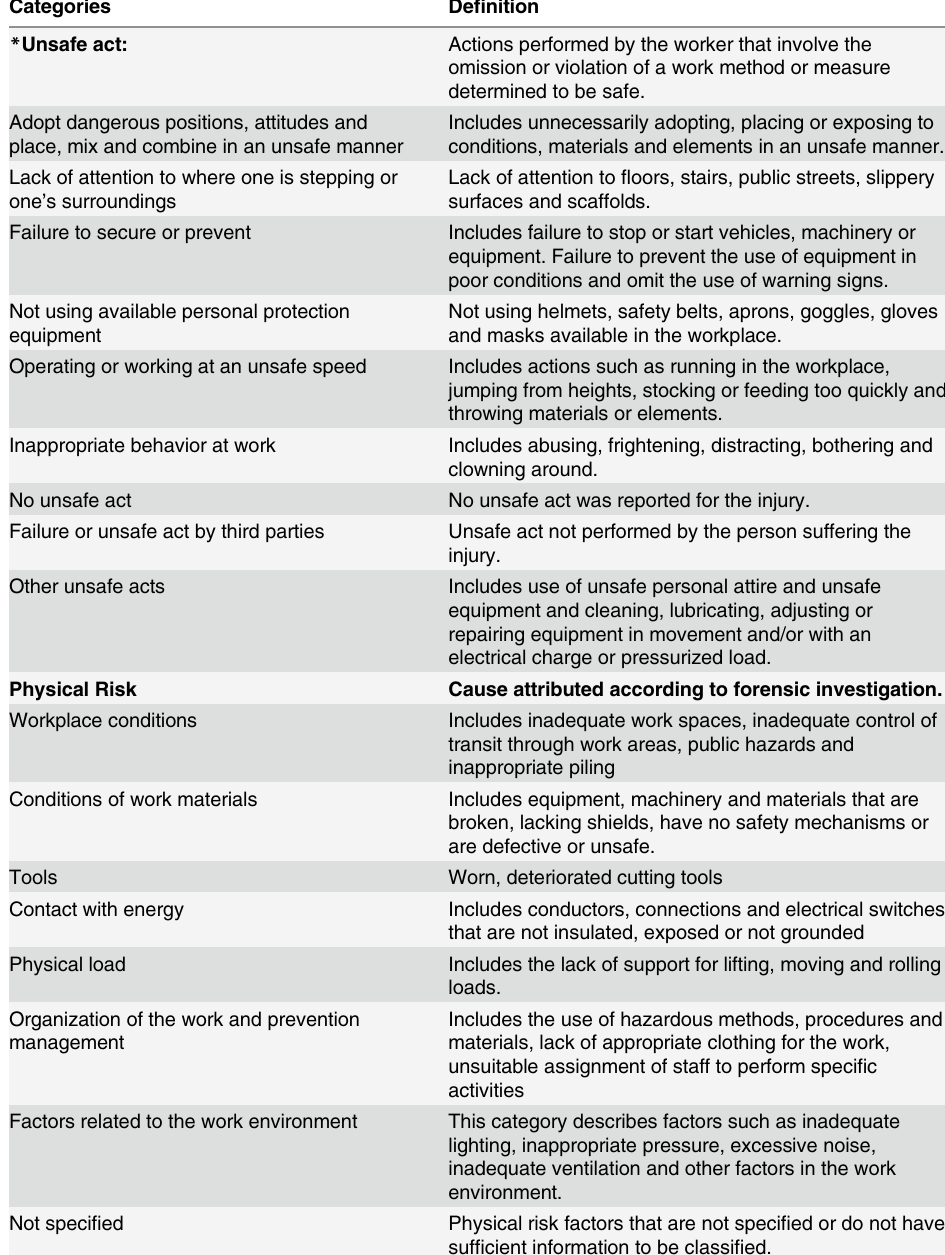
Table 1. De fi nitions of the categories of Unsafe act and Physical